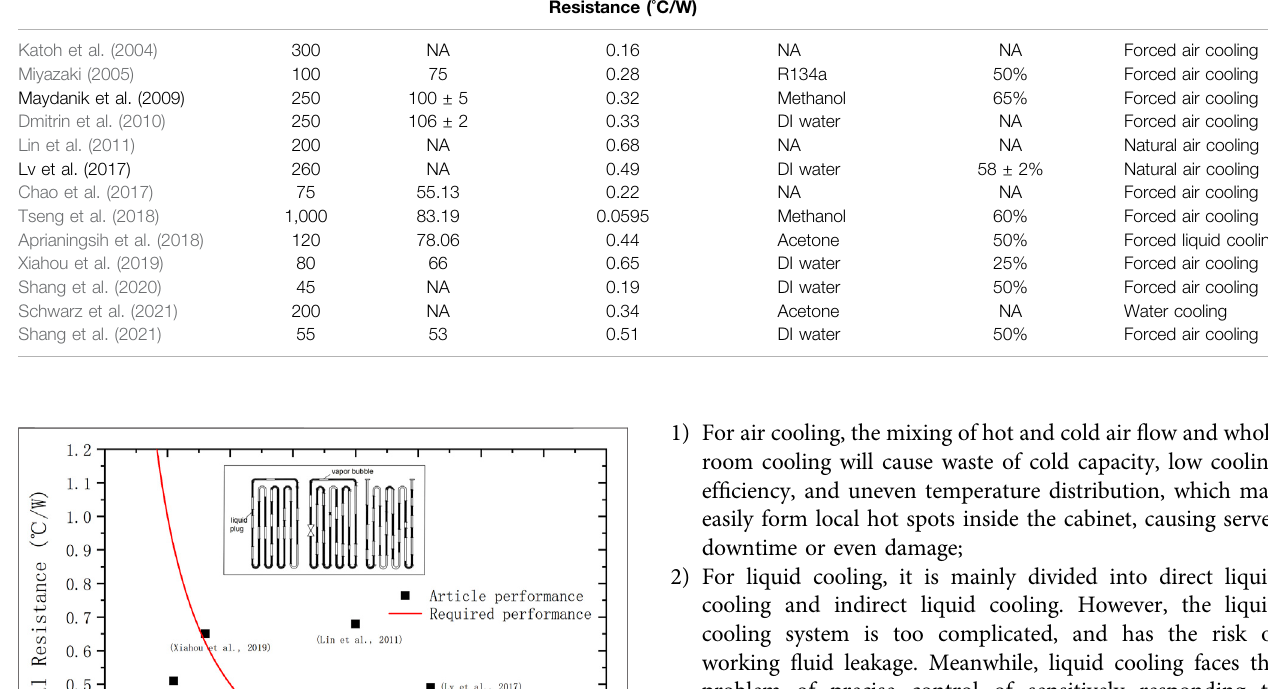
TABLE 3 | Summary of heat dissipation of high-power chips based on PHPs. Ref